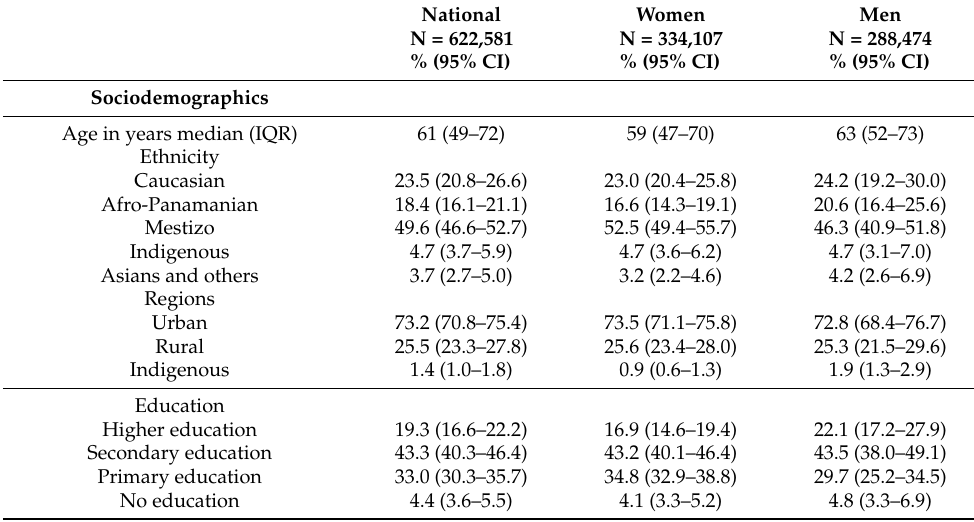
Figure 1. Flowchart of selected participants. n = study population. N = weighted study population. AMI = acute myocardial infarction. CVD = cerebrovascular disease. CKD = chronic kidney disease. MMAS-4 = Morisky medication adherence score-4 items. High Adherence defined as an MMAS-4 = 0, Low-moderate Adherence defined as an MMAS-4 > 0. Table 1. Baseline characteristics among treated hypertensive participants from the ENSPA study stratified by